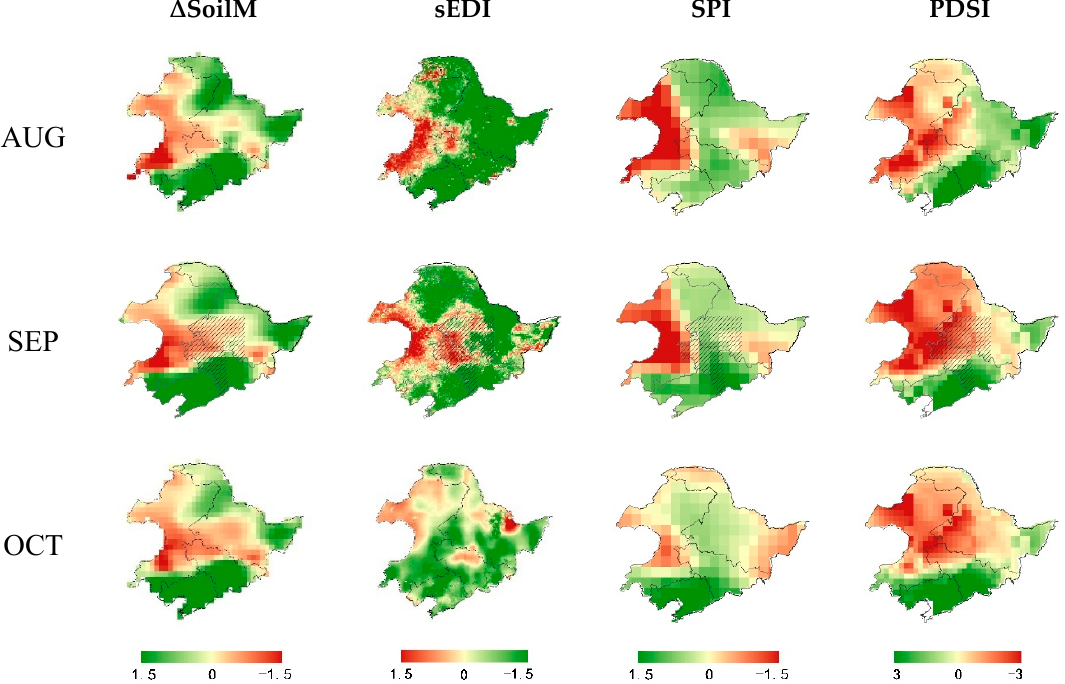
Figure 8. Monthly standardized anomalies in SoilM, EDI, SPI, and PDSI from August to October in 2010. Green indicates wetness and red indicates dryness. The dashed line refers approximately to a recorded dry patch.